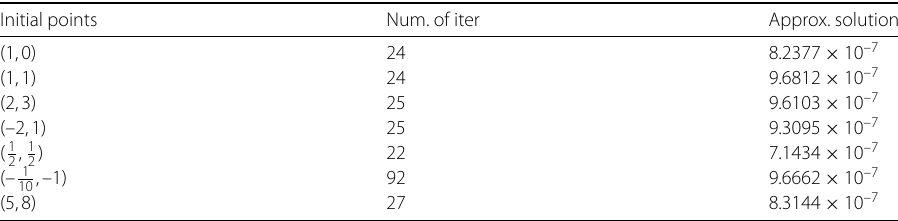
Table 3 Numerical illustration for the solution of variational inequality problem Initial points Num. of iter Approx.